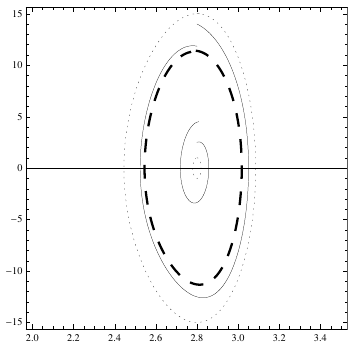
Figure 4. The middle dashed line represents a limit cycle, x (0) = 2 . 8, x (cid:48) (0) = 11 . 39. Two solutions are shown tending to the limit cycle, x (0) = 2 . 8, x (cid:48) (0) = 2 . 5, x (0) = 2 . 8, x (cid:48) (0) = 14. The period annulus of the conservative equation which transforms to the Poincar´e–Bendixson region for the Li´enard type equation is marked by two dotted closed inner and outer